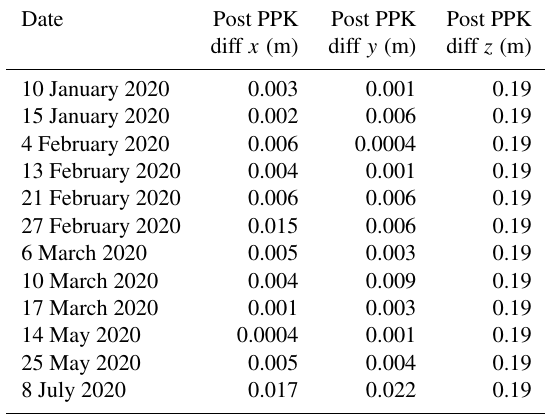
Table A1. Average locational error for UAS-collected imagery after PPK processing. Mean locational difference values are calculated from all images collected and processed on a given field day and have been calculated for x , y , and z (latitude, longitude, and eleva- tion, respectively)